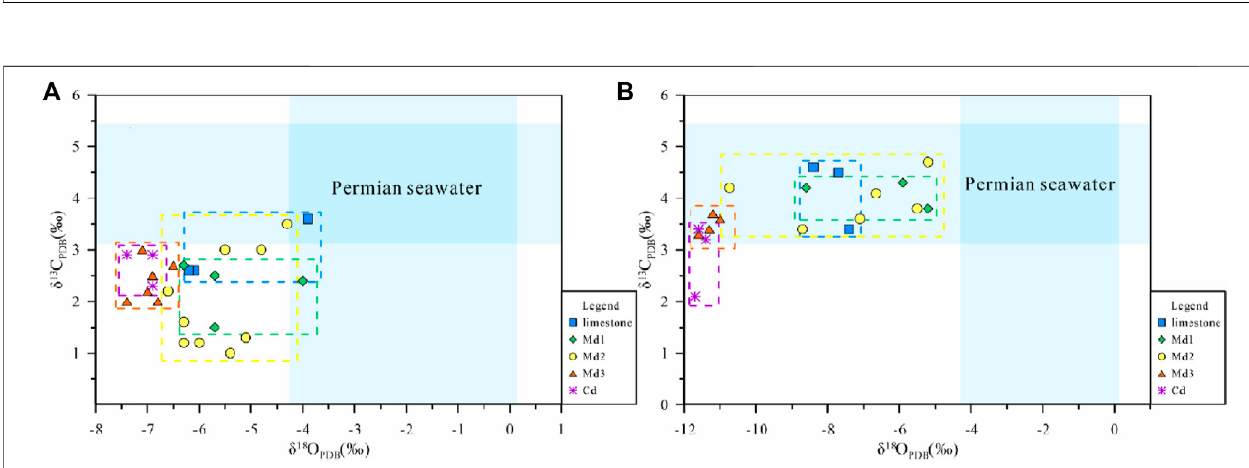
FIGURE 5 | Cross-plot of δ 13 C versus δ 18 O values of limestones and four types of dolomites in the Middle Permian compared to the Permian seawater (Buggisch et al., 2015). (A) Northwestern (NW) study area; (B) southwestern (SW) study area.